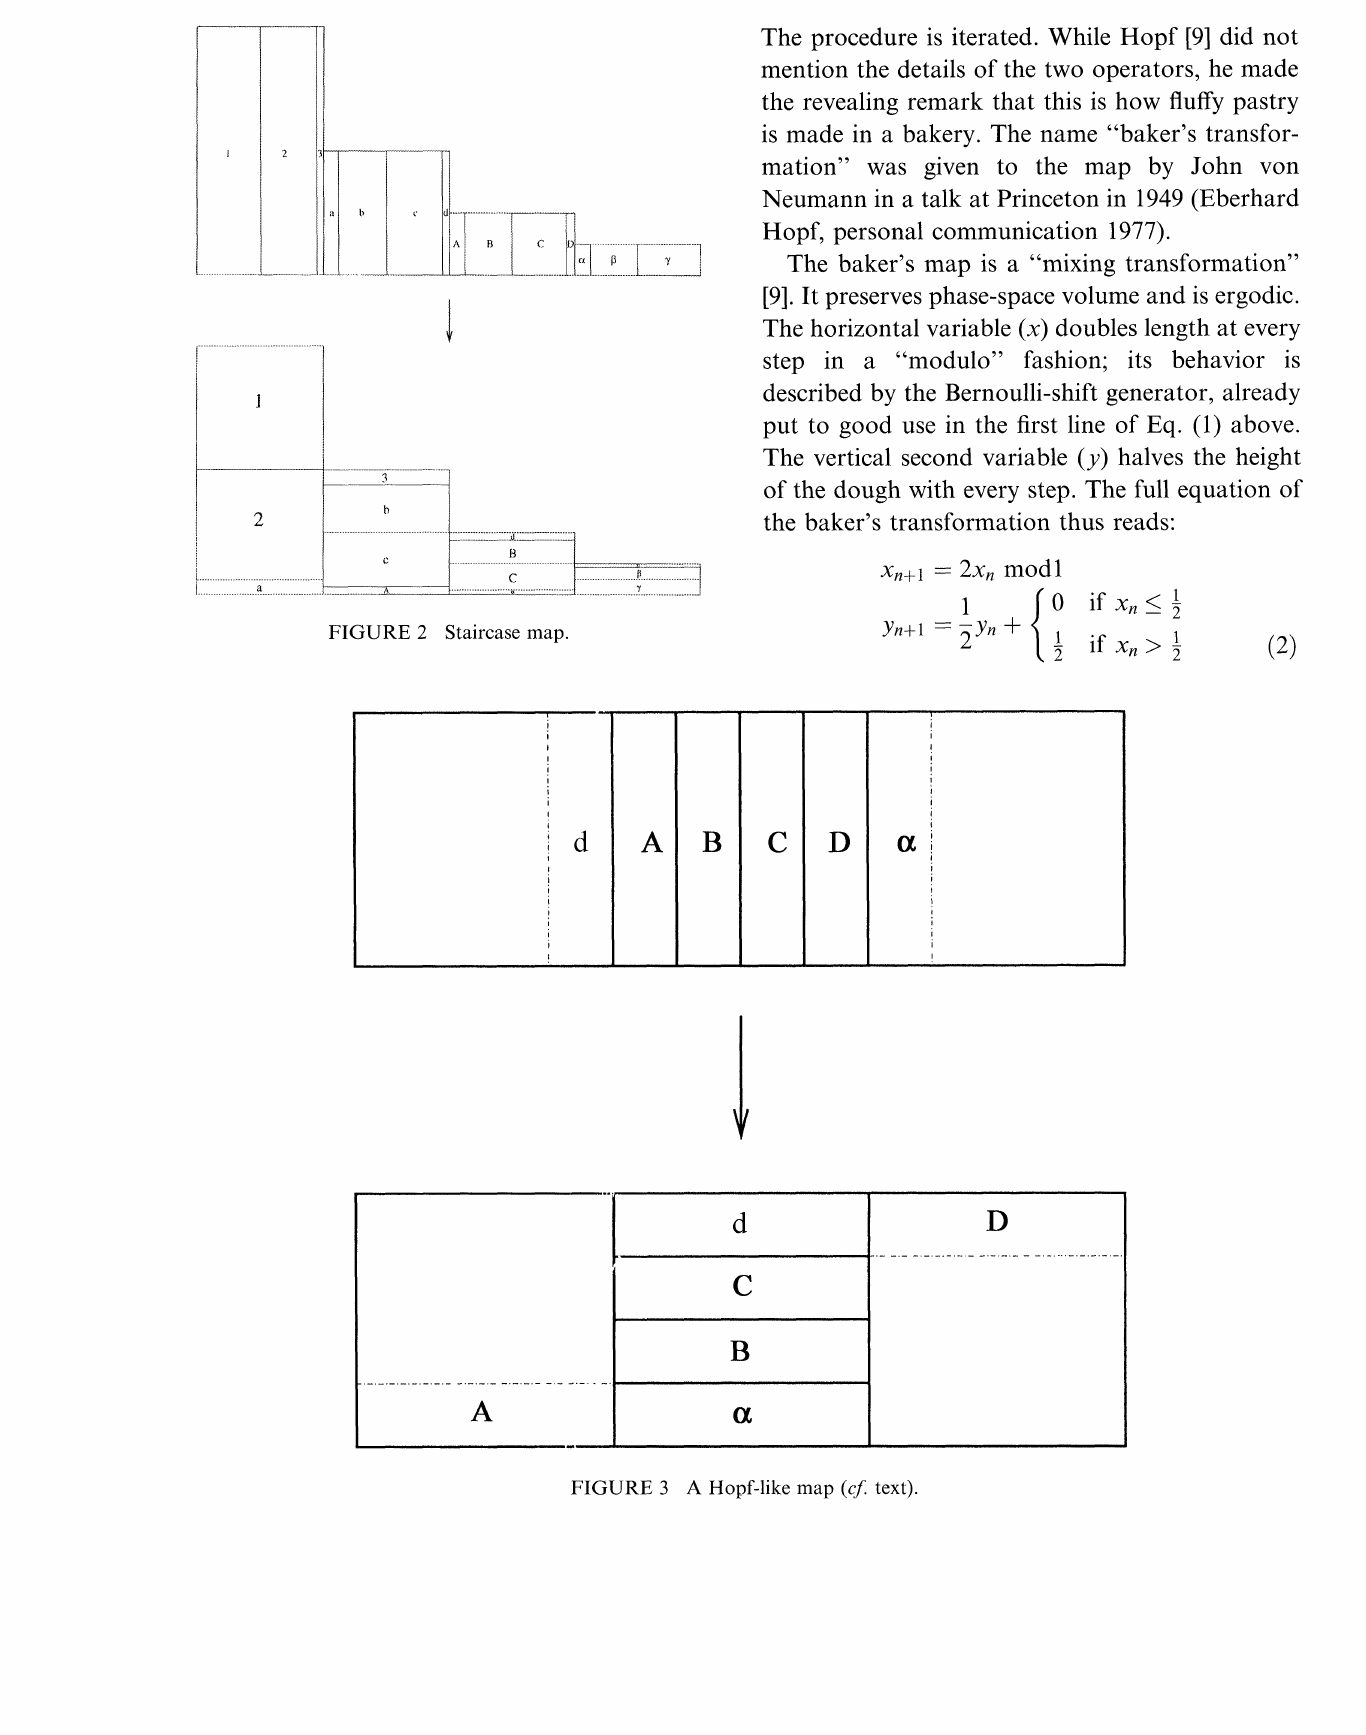
FIGURE 3 A Hopf-like map (cf.